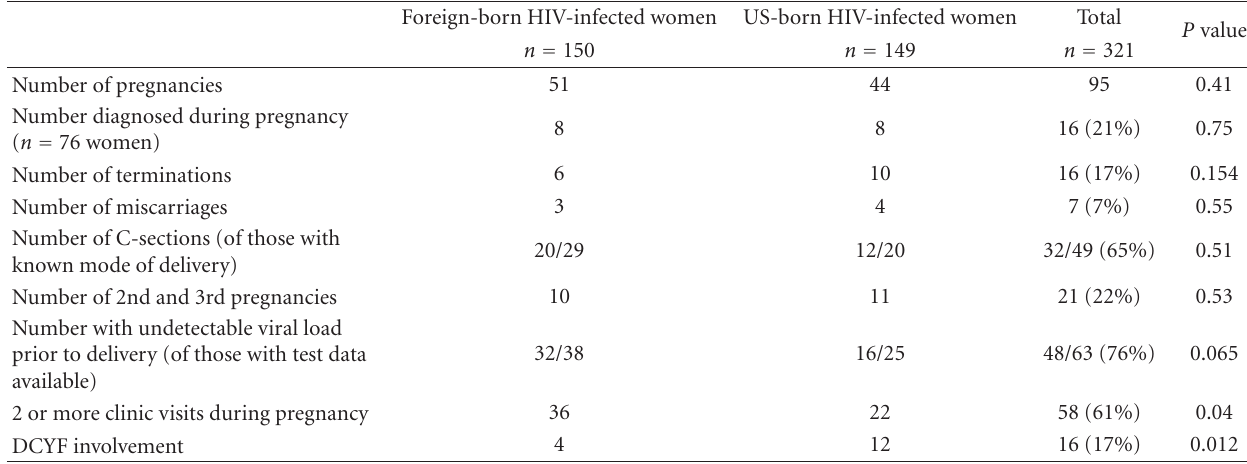
Table 2: Pregnancy outcomes among foreign-born versus US-born